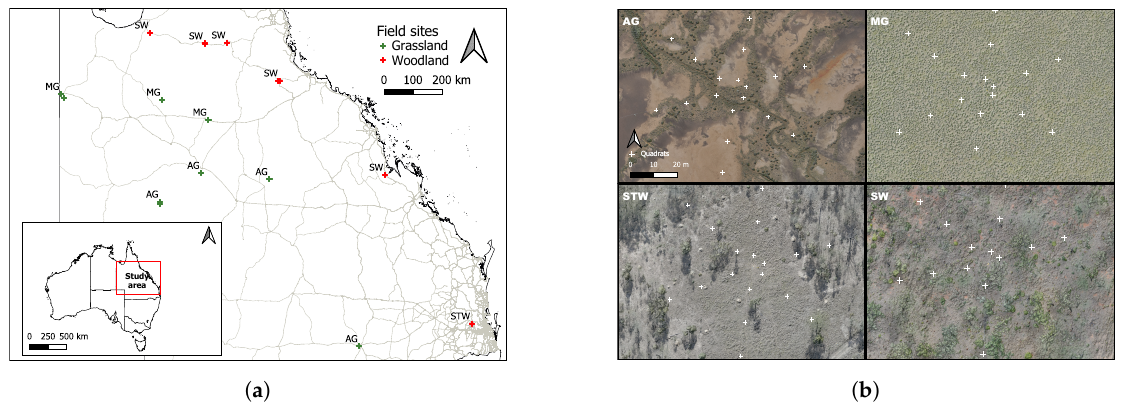
Figure 1. Locations of field sites ( a ), across the study area and their vegetation community and type. High-resolution Unmanned Aerial Vehicles (UAV) imagery examples ( b ) of each type including the arid grasslands (AG), Mitchell grasslands (MG), subtropical woodlands (STW) and (SW) savanna woodlands. Table 1. Field site